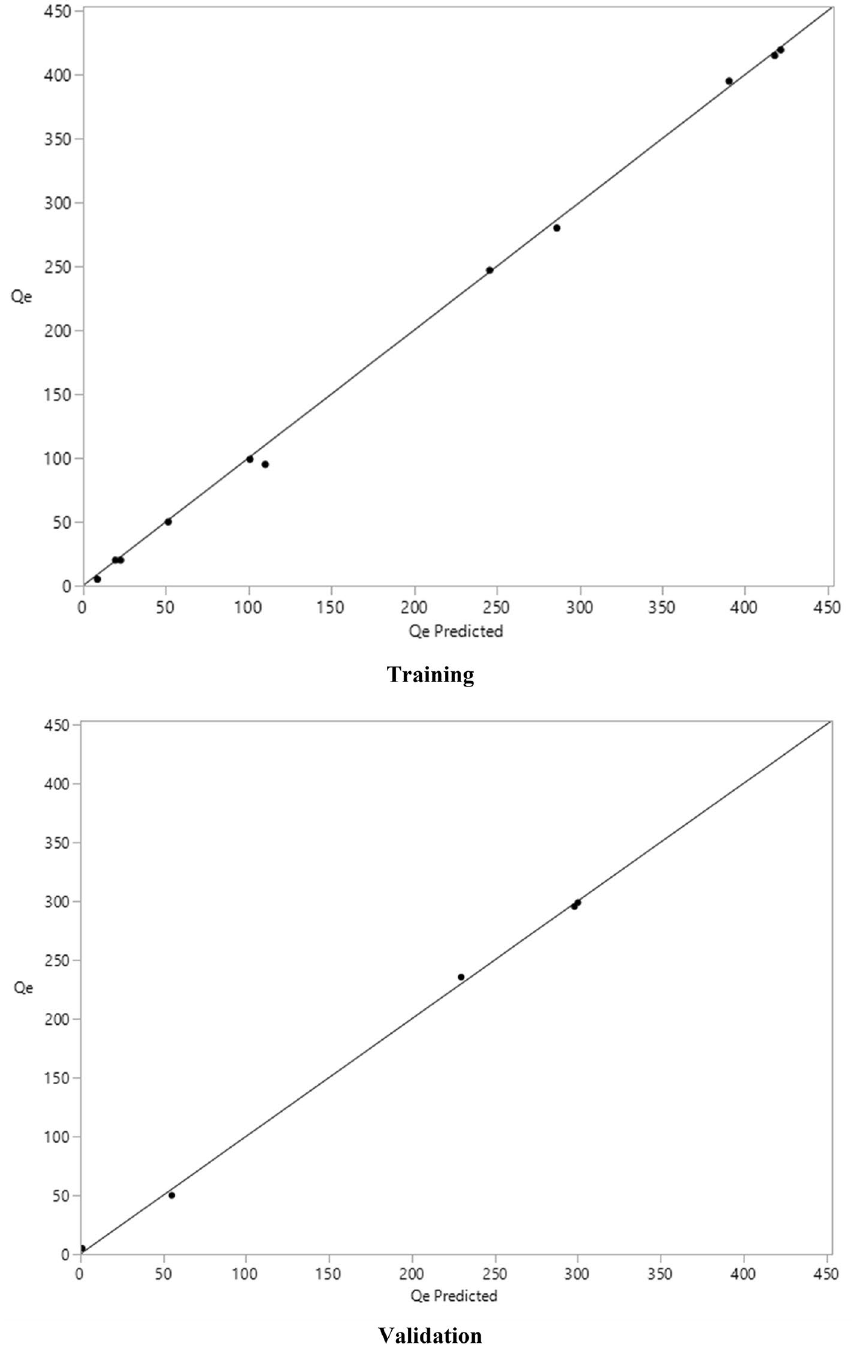
Figure 2. Training and validation data computed for removal of